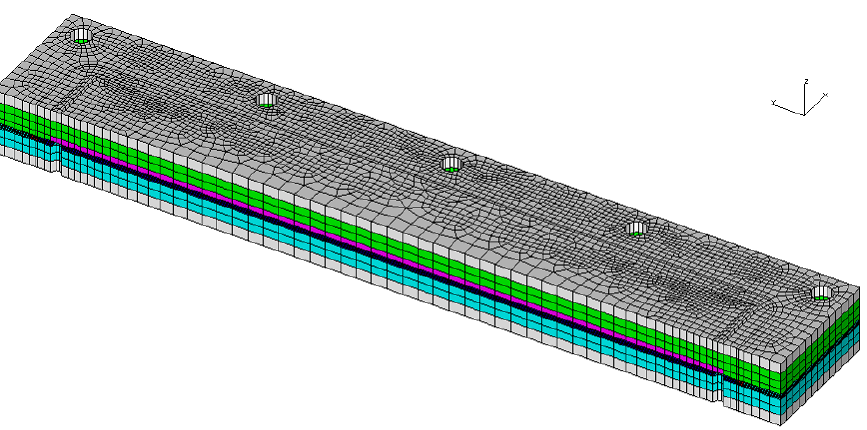
Figure 7. Finite element mesh used (half model).